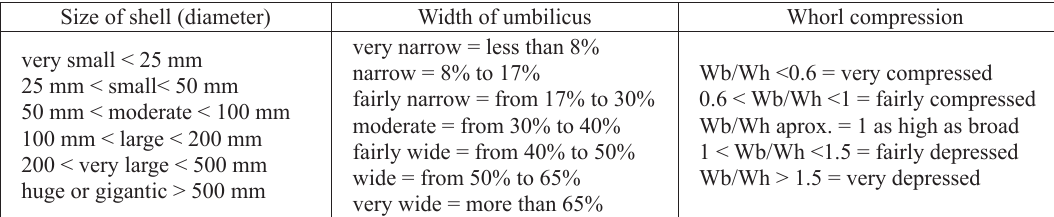
Table 1. Technical terms, dimensions, and morphological descriptions. Abbreviations: Wb, whorl breadth; Wh, whorl height. Size of shell (diameter) Width of umbilicus Whorl compression very narrow = less than 8% very small < 25 mm narrow = 8% to 17% Wb/Wh <0.6 = very compressed fairly narrow = from 17% to 30% 0.6 < Wb/Wh <1 = fairly compressed moderate = from 30% to 40% Wb/Wh aprox. = 1 as high as broad fairly wide = from 40% to 50% 1 < Wb/Wh <1.5 = fairly depressed wide = from 50% to 65% Wb/Wh > 1.5 = very huge or gigantic > 500 mm very wide = more than 65%